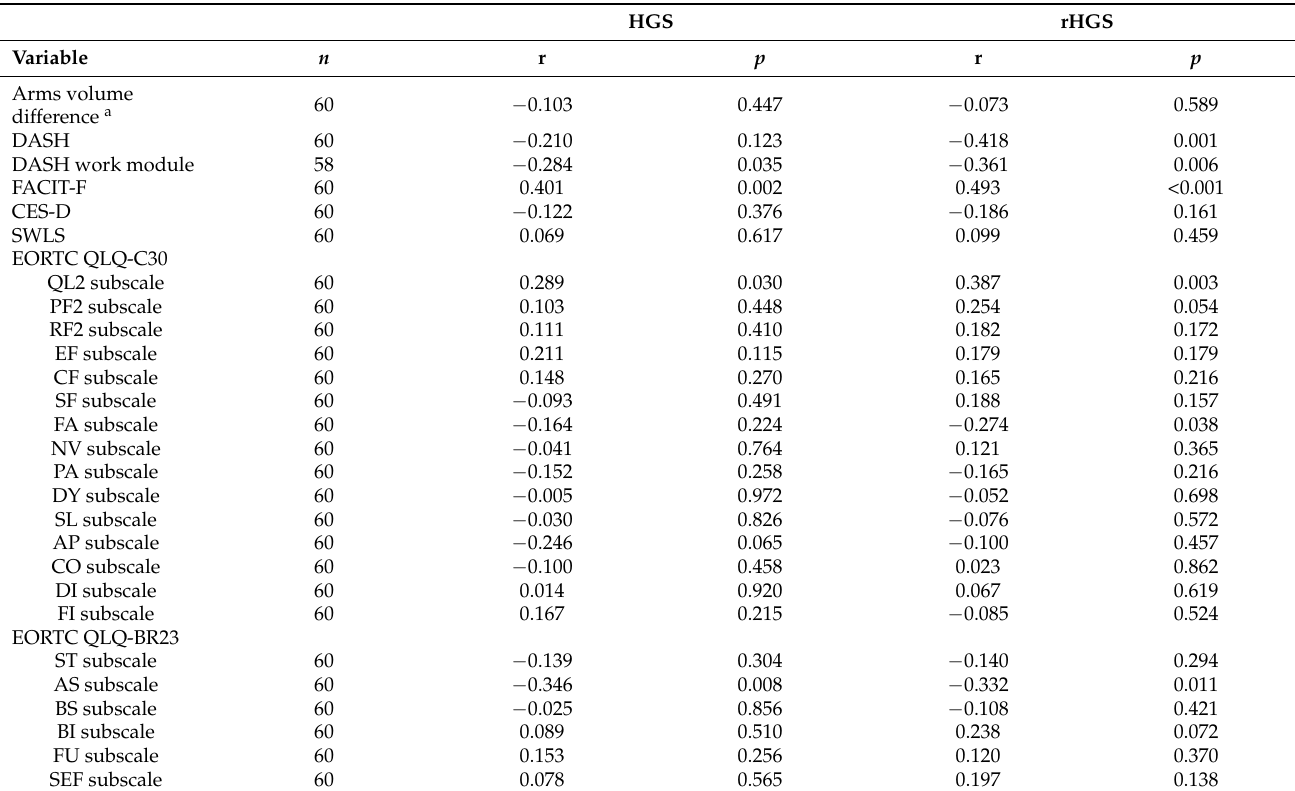
Table 2. Partial correlation assessing the association of HGS, and rHGS with arms volume difference, shoulder–arm disabilities, fatigue, depressive symptoms, life satisfaction and self-reported HRQoL in female breast cancer survivors.